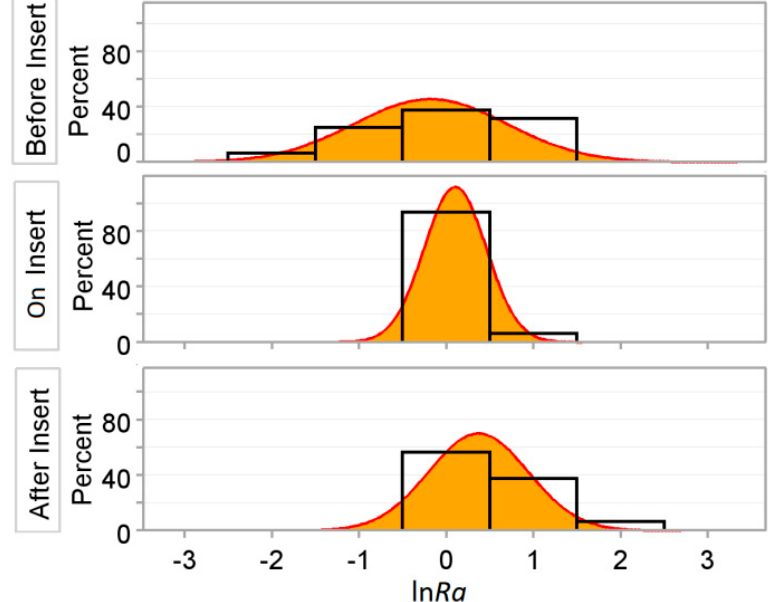
Figure 7. Distribution of the Naperian logarithm of the surface roughness (ln Ra ) for each of the three levels of measurement location on the insert ( LRI ).